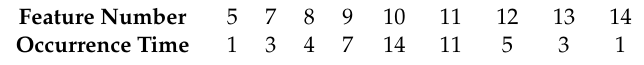
Table 13. Occurrence times for feature numbers.